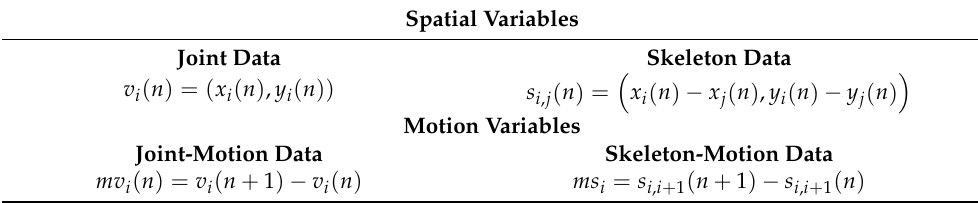
Table 1. The indexes of the joints and relations between every two adjacent joints at the 17